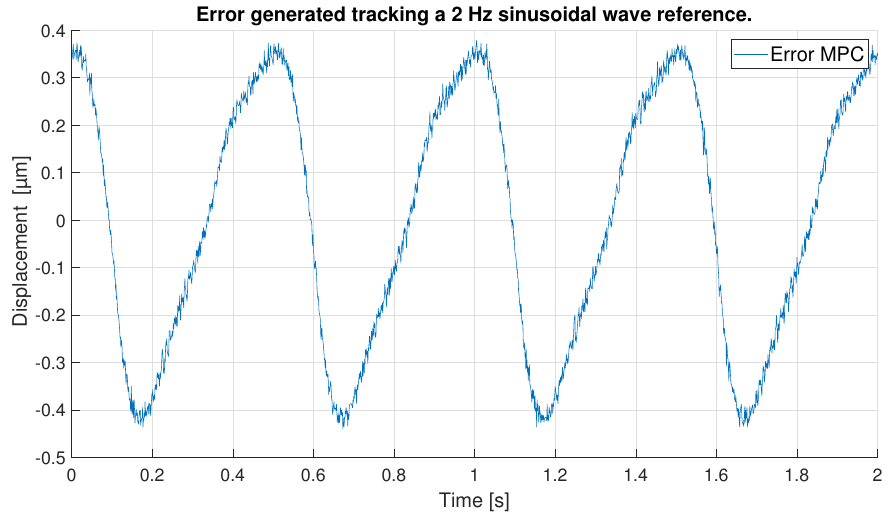
Figure 25. Error of tracking of the MPC for a 2 Hz sinusoidal reference of full amplitude.